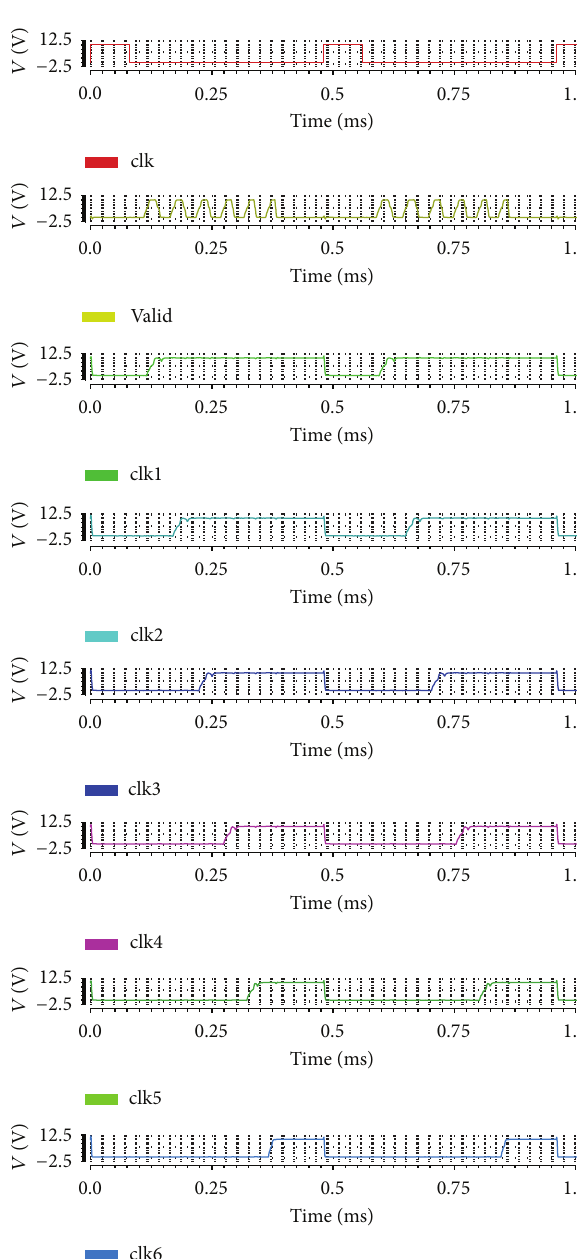
circuits thanks to creating their valid models with the OPDK added in Cadence. The organic circuits, including logic gates, flip-flops, comparators, and analog-to-digital convert- ers (ADCs), work properly in biopotential frequency ranges. The SAR ADC achieves 5.05-bit ENOB, 32.17 dB SNR with a power consumption of 883.7 𝜇 W at 10 V supply voltage, and 2 KHz clock pulses. With above-mentioned results, we strongly believe that the models can help to save the time and cost in organic IC design and